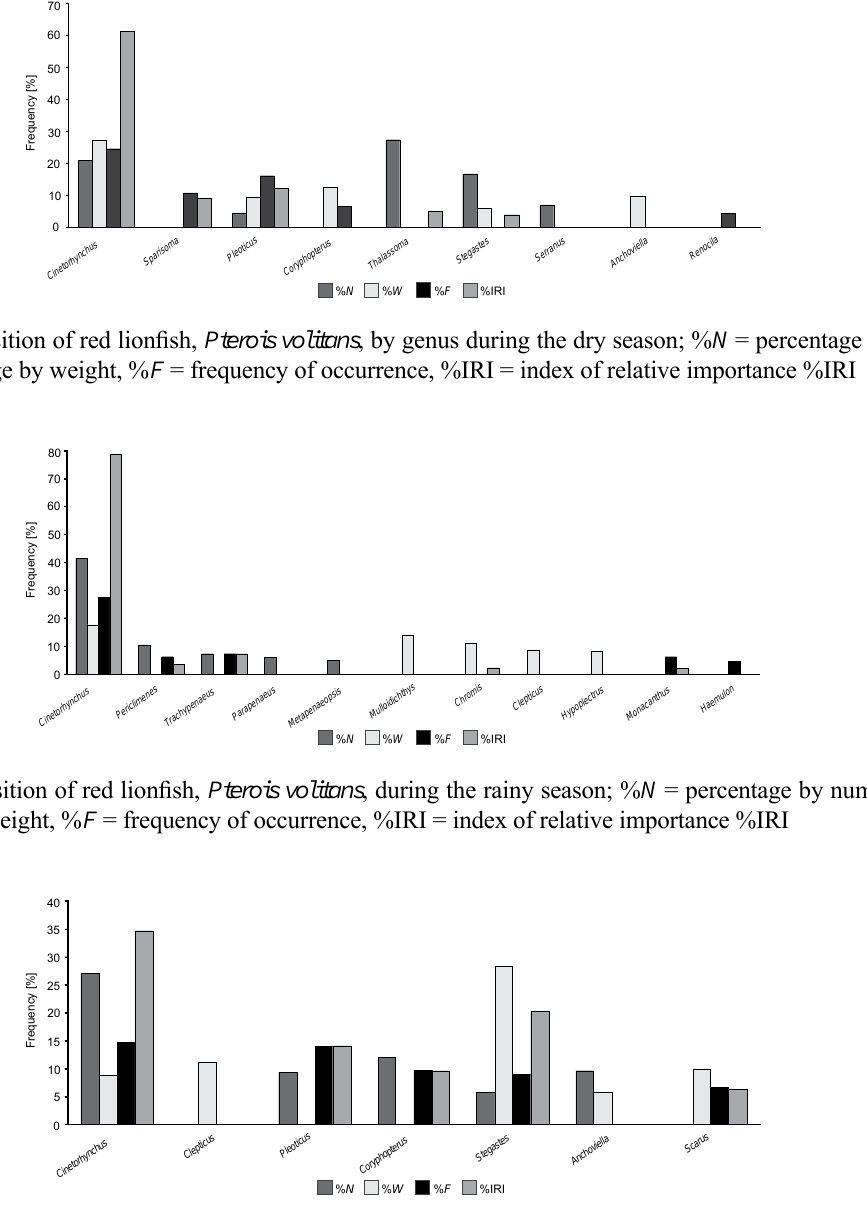
Fig. 8. Diet composition of red lionfi sh, Pterois volitans , during the nortes season; % N = percentage by number, % W = percentage by weight, % F = frequency of occurrence, %IRI = index of relative importance